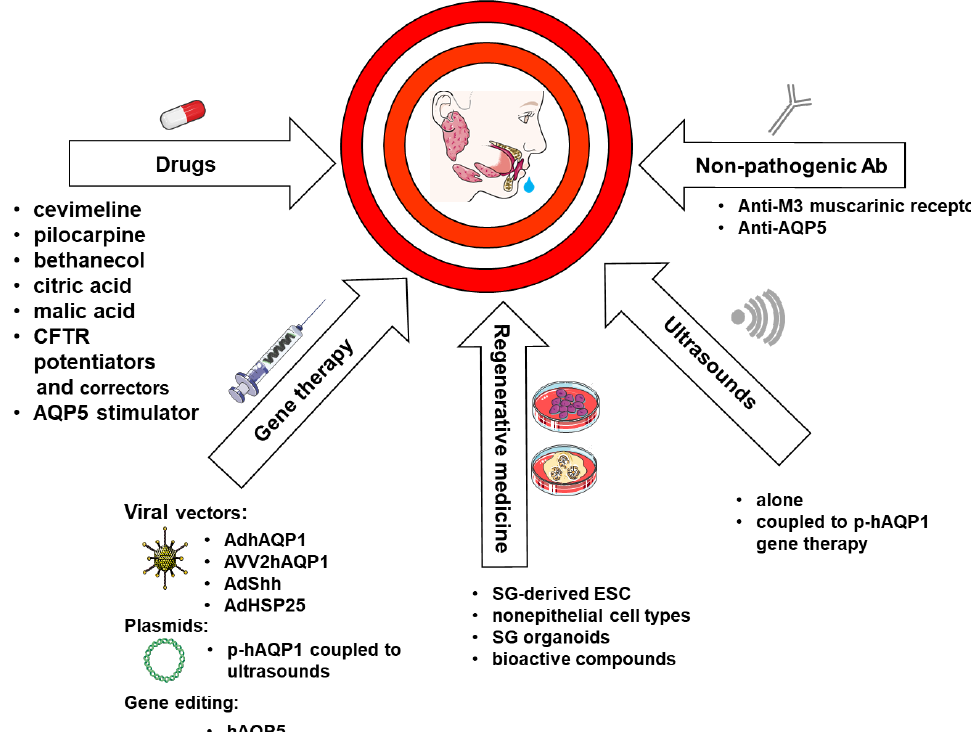
Figure 5. Current and future therapeutic strategies, including AQPs, to treat xerostomia. The diagram recapitulates di ff erent treatment strategies (drugs, gene therapy, regenerative medicine, ultrasounds, non-pathogenic Ab) to restore loss of function, to prevent or to treat the common symptoms and / or consequential